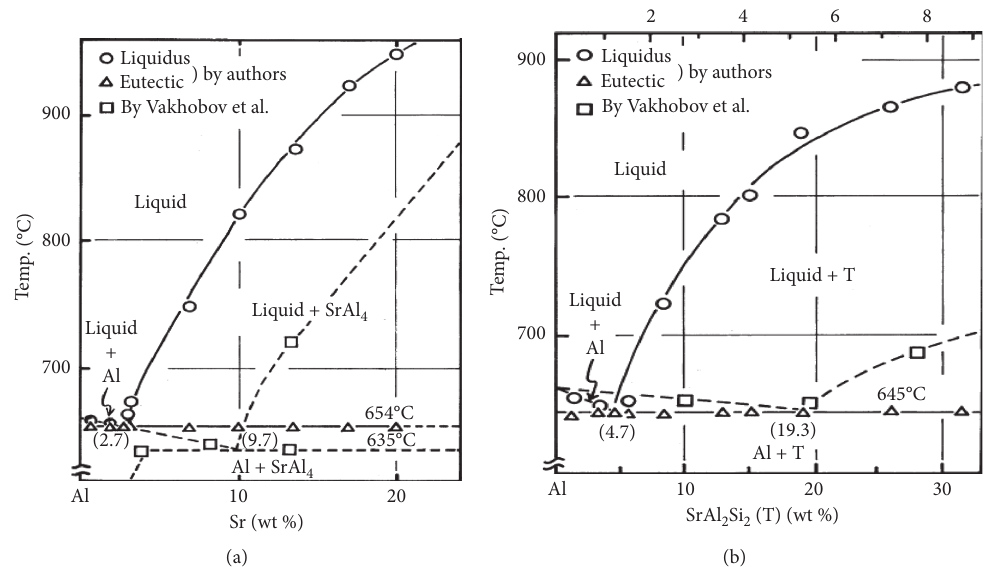
2 Si 2 (T) quasibinary